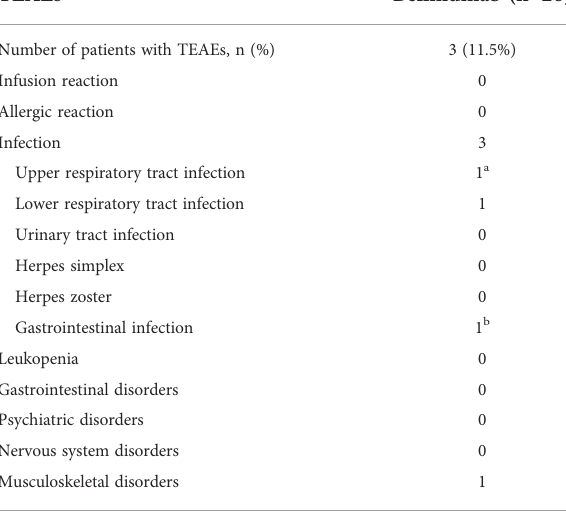
TABLE 3 Treatment-emergent adverse events (TEAEs) that occurred during the period of belimumab treatment.